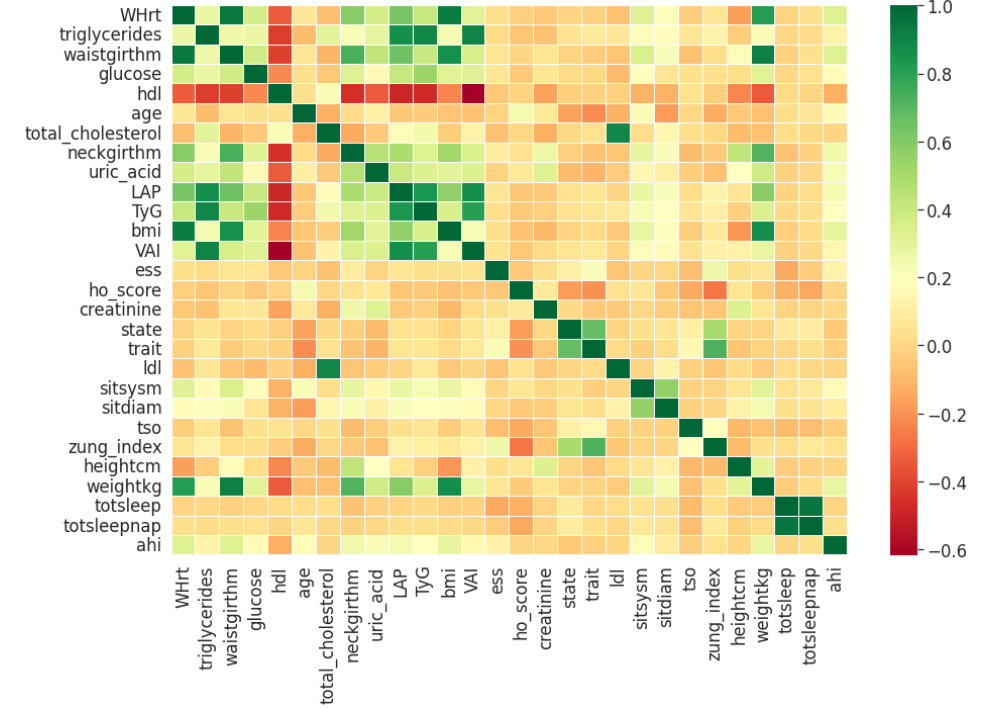
Figure 2. Clinical features ordered as per Pearson’s Correlation